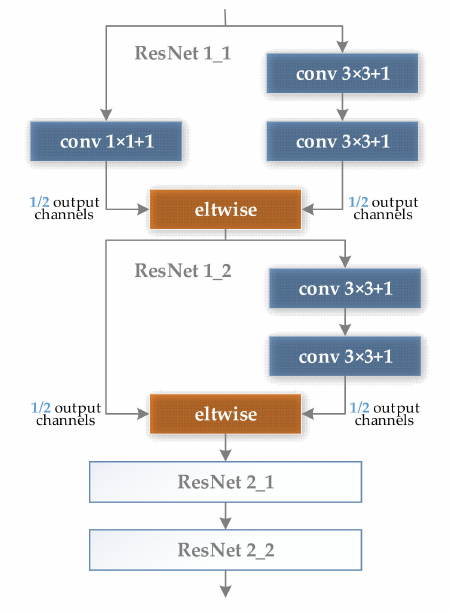
Figure 3. Two residual modules in series structure.